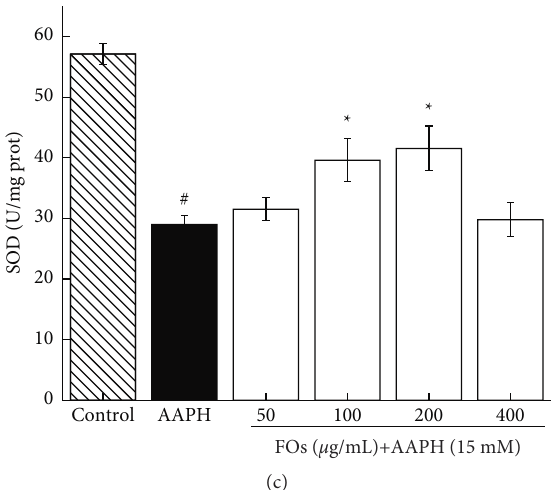
Figure 7: The effects of various concentrations of FOs-FWB on the activity of CAT (a), GSH-Px (b), and SOD (c), in AAPH-stimulated zebrafish embryos. The data are expressed as the mean ± SE ( n � 3). # Indicates significant differences from control. ∗ Indicates significant differences from AAPH. FOs-FWB: feruloyl oligosaccharides from fermented wheat